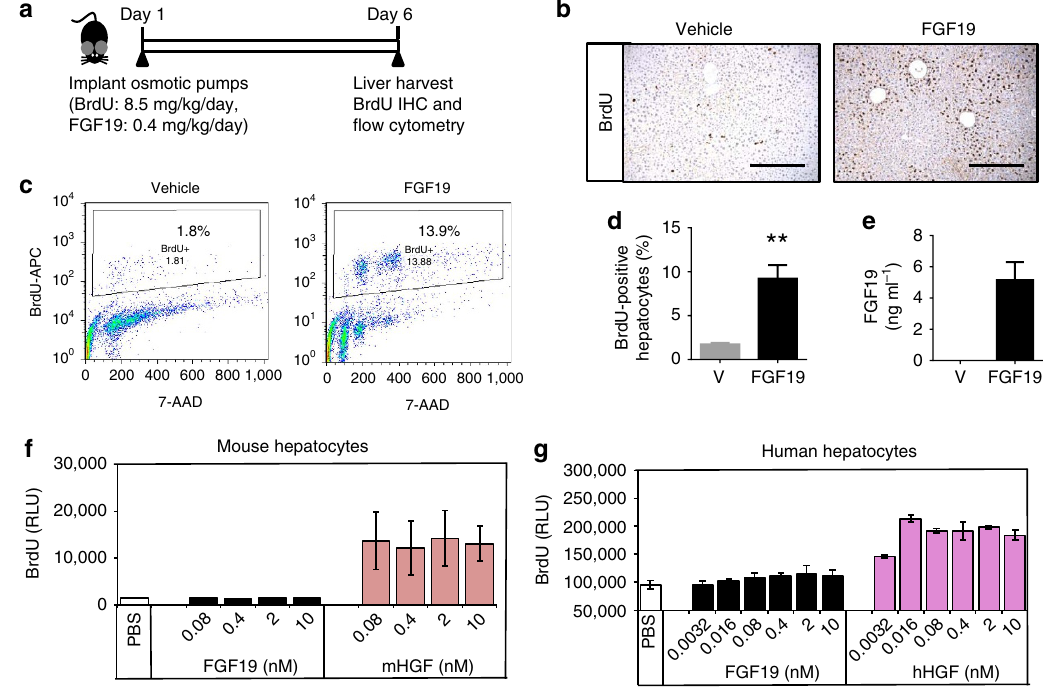
Figure 4 | Non-cell-autonomous promotion of hepatocellular proliferation by FGF19. ( a ) in vivo study design. Mice ( n ¼ 5 per group) were implanted with osmotic pumps releasing BrdU (8.5mgkg (cid:3) 1 day (cid:3) 1 ) and FGF19 protein (0.4mgkg (cid:3) 1 day (cid:3) 1 ). Livers were harvested 6 days post implant. ( b ) BrdU incorporation in liver in vivo was revealed by staining with anti-BrdU antibody followed by DAB substrates (brown colour). Sections were counter- stained with hematoxylin. Scale bars, 100 m m. ( c ) Flow cytometry analysis of BrdU-labelled livers. Representative histograms from hepatocytes stained with anti-BrdU-APC and 7-AAD are shown. ( d ) BrdU-positive hepatocytes as a percentage of total hepatocytes from vehicle (V)-treated or FGF19-treated mice were quantified by flow cytometry. ( e ) Circulating FGF19 levels on day 6 post-implant of osmotic pumps. ( f ) Lack of proliferative effects of FGF19 on primary mouse hepatocytes. Primary cultures of hepatocytes isolated from mouse liver were incubated with recombinant FGF19 protein at indicated concentrations for 48h, and BrdU was added during the last 24h of incubation. BrdU incorporation was determined using a luminescence method. Mouse hepatocyte growth factor (mHGF) was included as a positive control. RLU, relative luminescence unit. ( g ) Lack of proliferative effects of FGF19 on primary human hepatocytes. Primary cultures of hepatocytes isolated from human liver were incubated with recombinant FGF19 protein. Human hepatocyte growth factor (hHGF) was included as a positive control. Data are represented as mean ± s.e.m. ** P o 0.001 versus control group by unpaired, two-tailed t